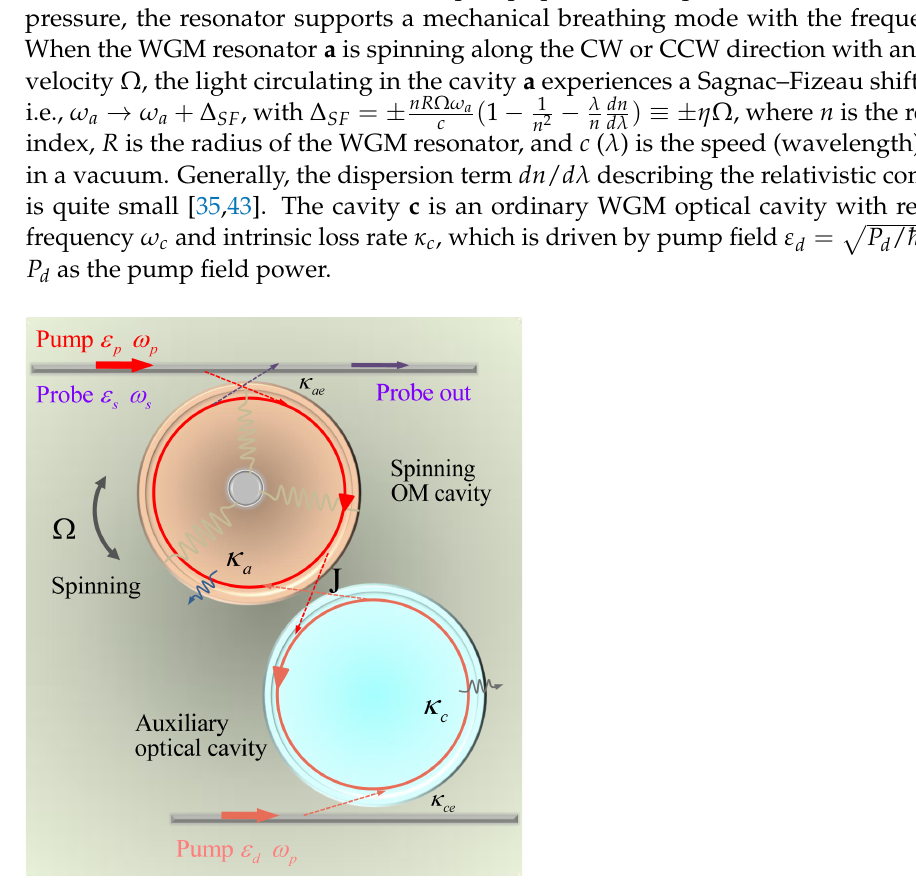
Figure 1. Schematic diagram of the photonic molecule spinning optomechanical system, which includes a spinning optomechanical cavity and one ordinary auxiliary optical cavity. The optome- chanical cavity is driven by a pump field and a probe field, while the auxiliary optical cavity is only driven by a pump field. The spinning optomechanical cavity can spin along the CW and CCW direction, and J indicates the coupling of the two